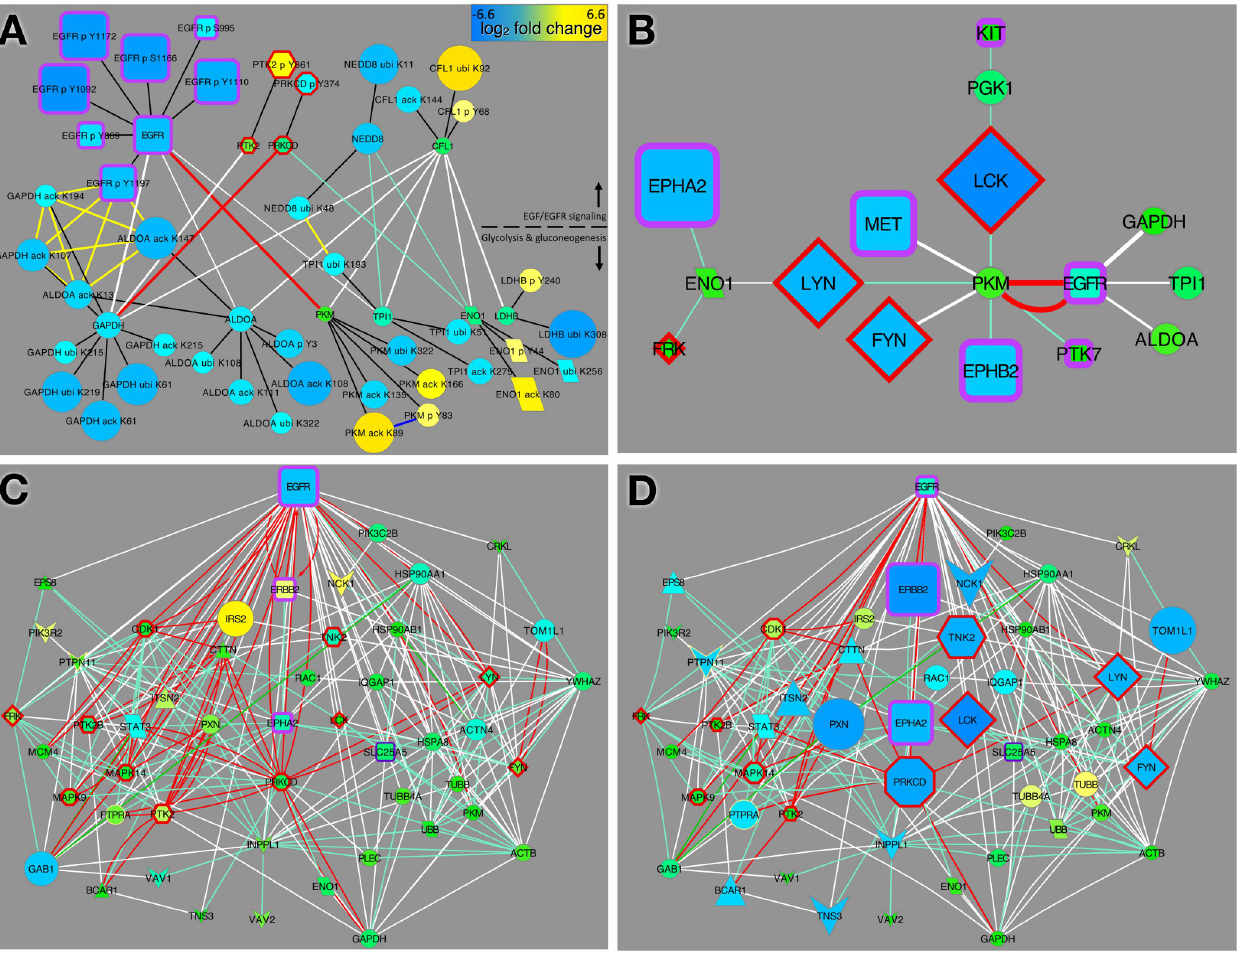
Fig 4. EGFR signaling and glycolysis pathway interactions. (A) Direct CFN connections between proteins in the EGFR signaling and glycolysis pathways and their PTMs that are significantly changed by erlotinib (median fold change in erlotinib-treated vs. control cells at least 2.25). (B) CFN connections between RTKs and SFKs and Glycoylsis and gluconeogenesis pathway proteins. (C, D) Sub-network from EGFR-glycolysis shortest paths CFN (see S10B Fig) showing links between EGFR and top proteins with dasatinib-inhibited PTMs. Node shape and edge color are defined in S2C Fig. Node size and color represents log 2 fold change (bar in A) for all EGFR-mutant cell lines treated with erlotinib (A, C) or dasatinib (B,